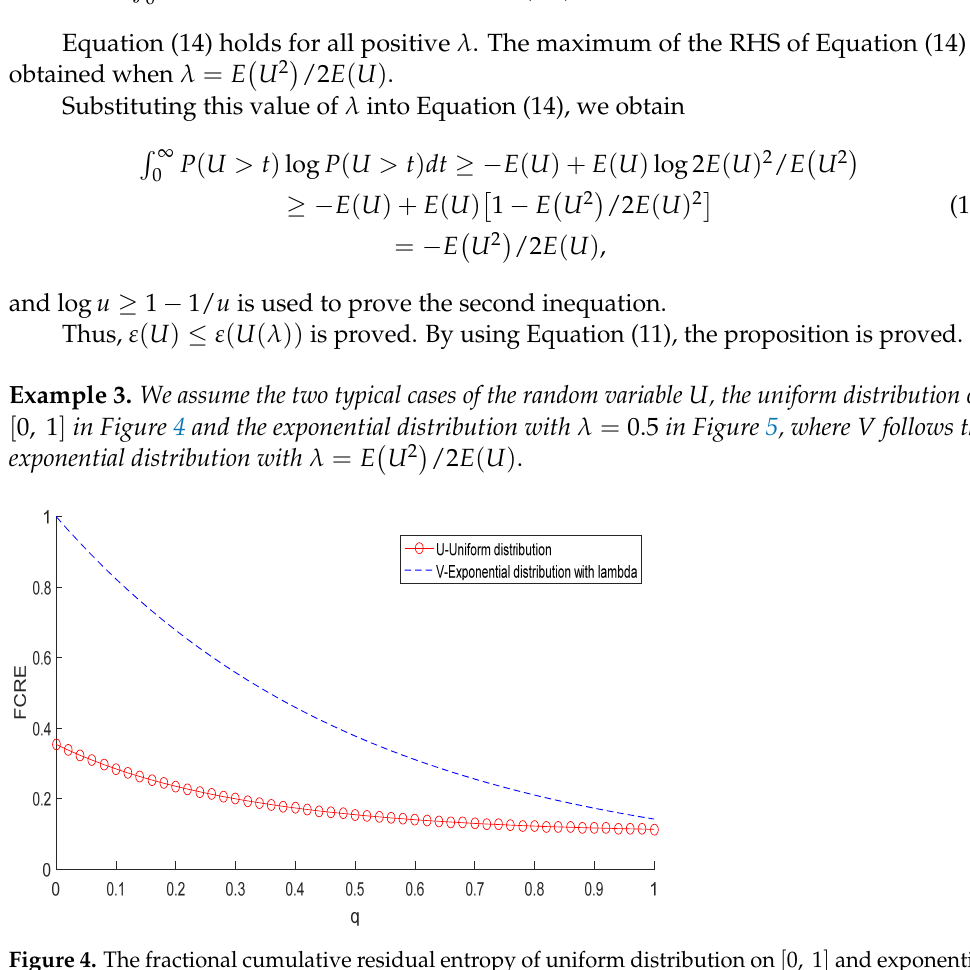
Figure 4. The fractional cumulative residual entropy of uniform distribution on [ 0, 1 ] and exponential ( (cid:0) (cid:1) distribution . U 2 distribution λ = E /2 E ( U )